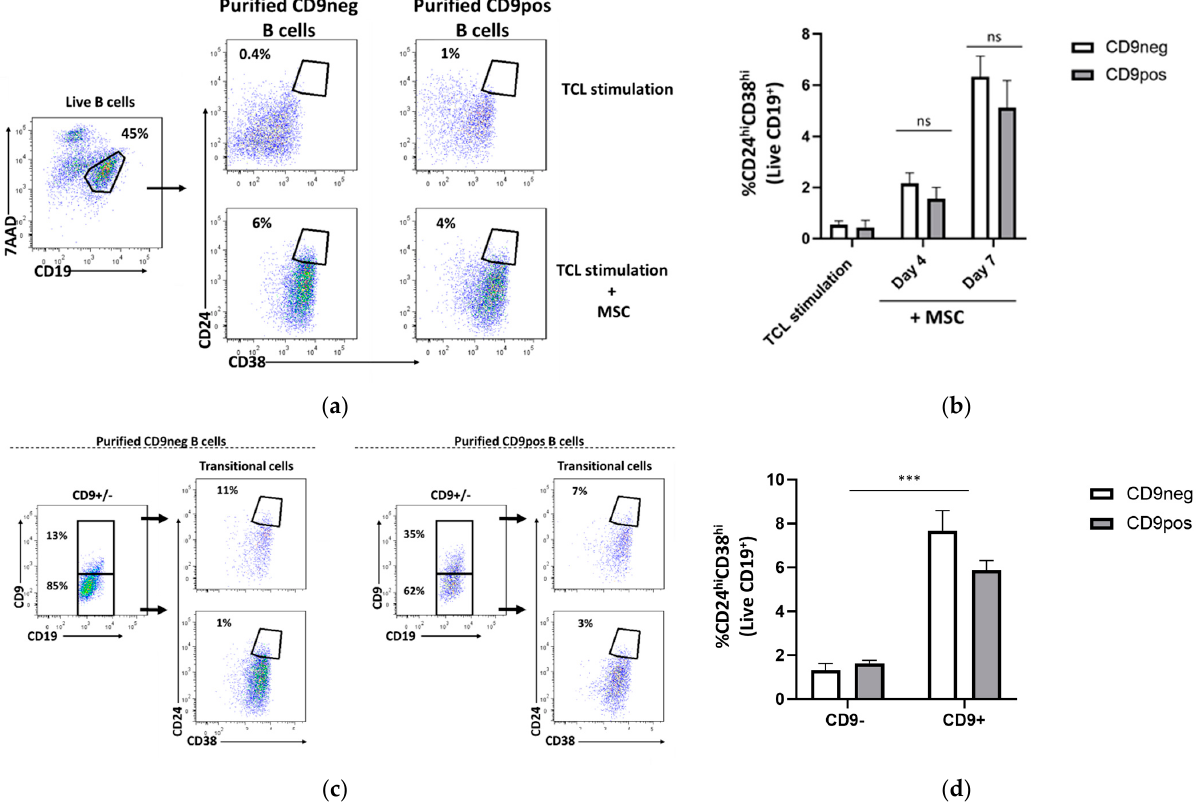
Figure 4. Transitional B cells can be induced in both purified CD9 negative- and positive-B cells at a similar level. Tonsil cells were sorted into purified CD9neg and CD9pos B cells then cultured under the transitional cell-inducing condition with T cell-like (TCL) stimulation + mesenchymal stem cells (MSC). At days 4 and 7, the frequency of CD24 hi CD38 hi transitional B cells in both purified populations were examined. ( a ) Gating strategy and representative dot plots of transitional cell induction in purified samples. ( b ) No significant differences in the induction of transitional cells in both purified populations. Purified CD9neg and CD9pos B cells were re-stained for CD9 at day 7 of incubation and the frequency of CD24 hi CD38 hi was analyzed within gated CD9 − and CD9 + cell in both purified populations. ( c ) Gating strategy and representative dot plots. ( d ) The frequency of CD24 hi CD38 hi was significantly higher within gated CD9 + B cells as compared to CD9- in both purified populations. Data show at least three independent experiments in each group; ns (non-significant) p > 0.05, *** p < 0.001; two-way ANOVA was performed to determine statistical